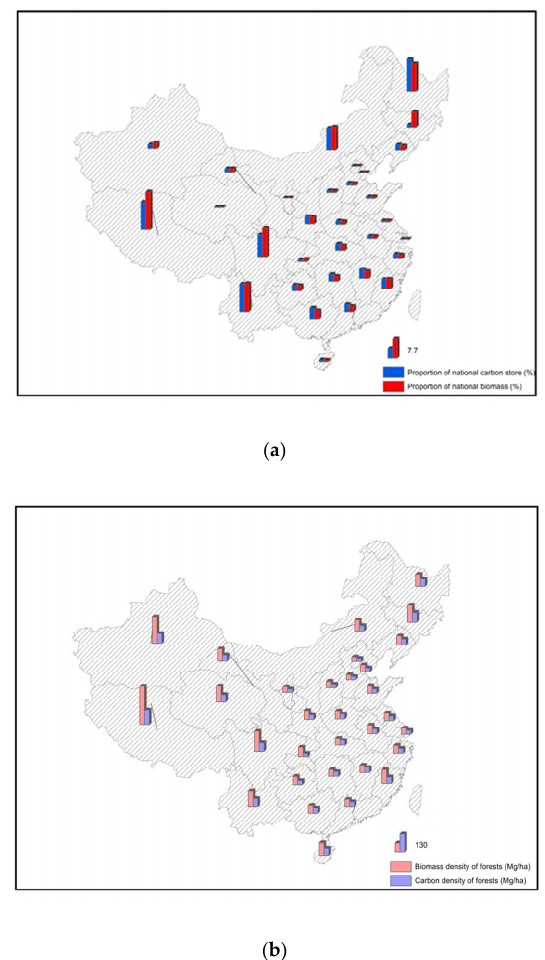
Figure 7. ( a ) Arboreal forest carbon store statistics by province; ( b ) Arboreal forest carbon density statistics by province.